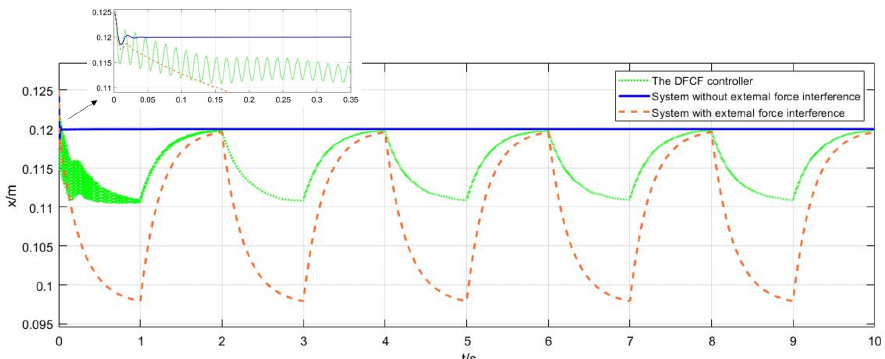
Figure 7. Effect of the DFCF against square wave external force interference.